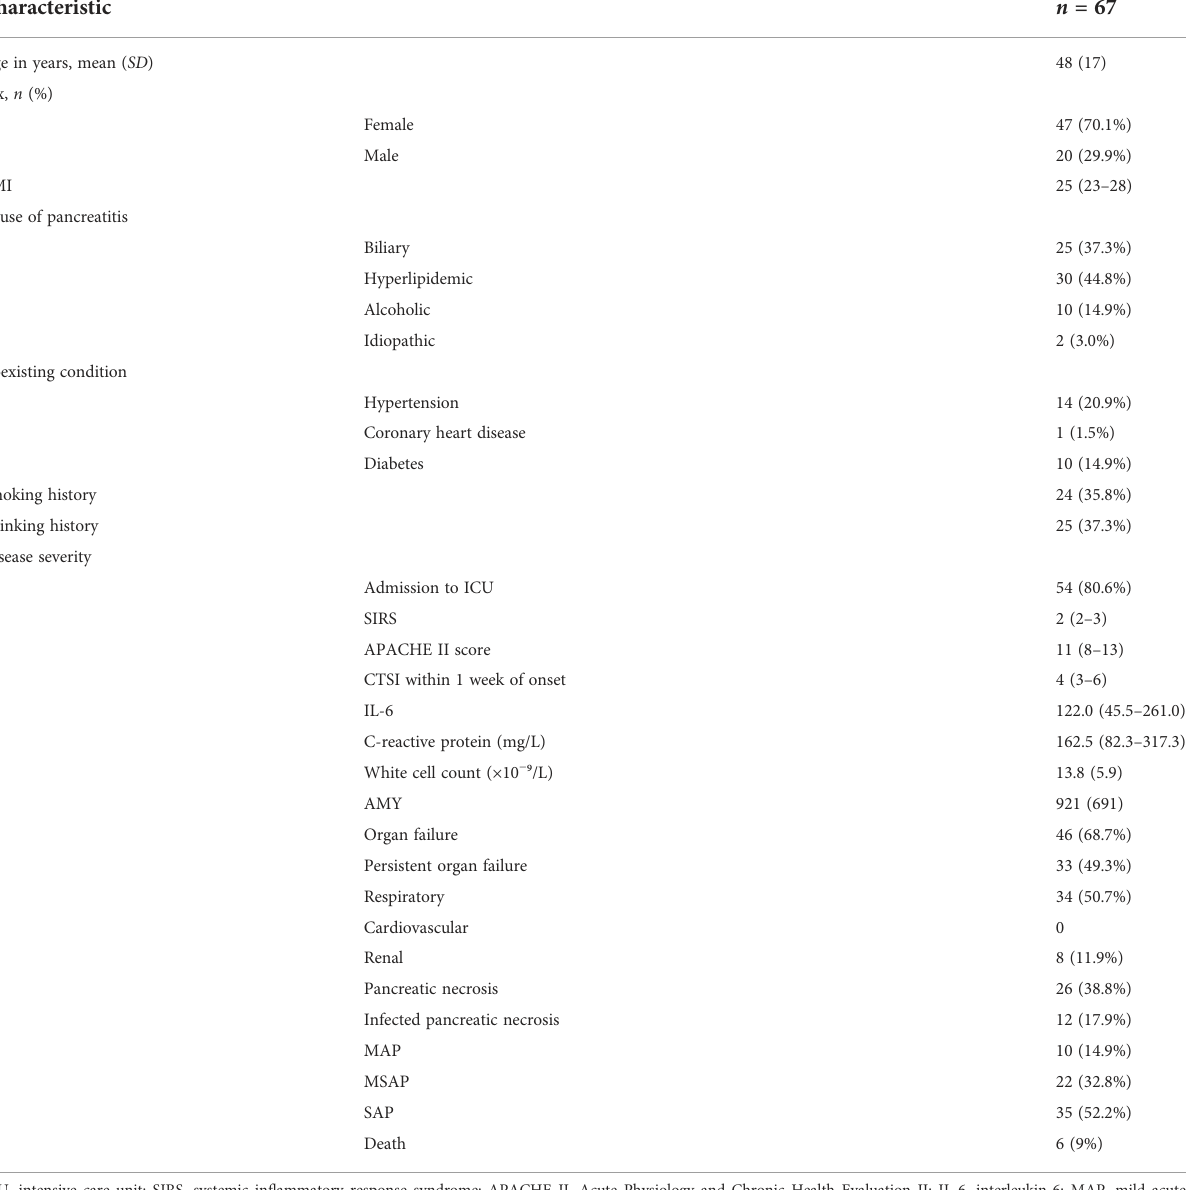
TABLE 2 Patient demographics and baseline